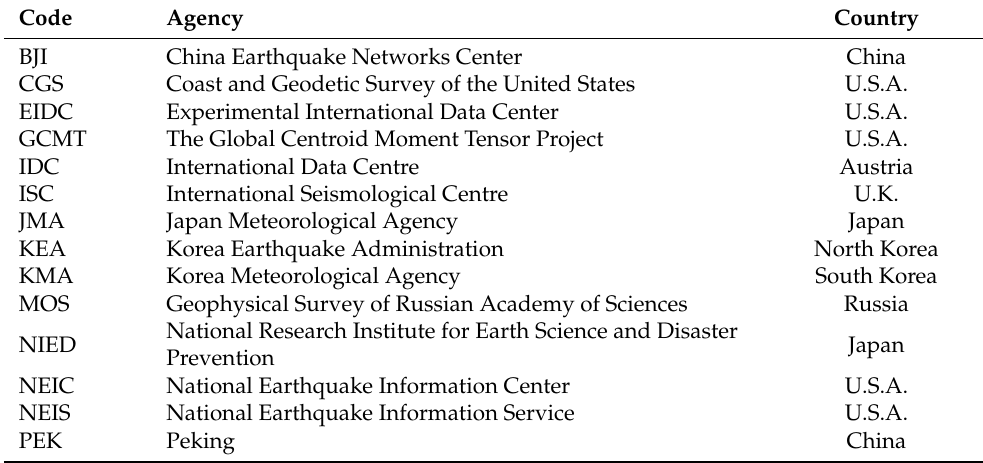
Table 1. Seismological agencies that supplied relevant earthquake event data for this